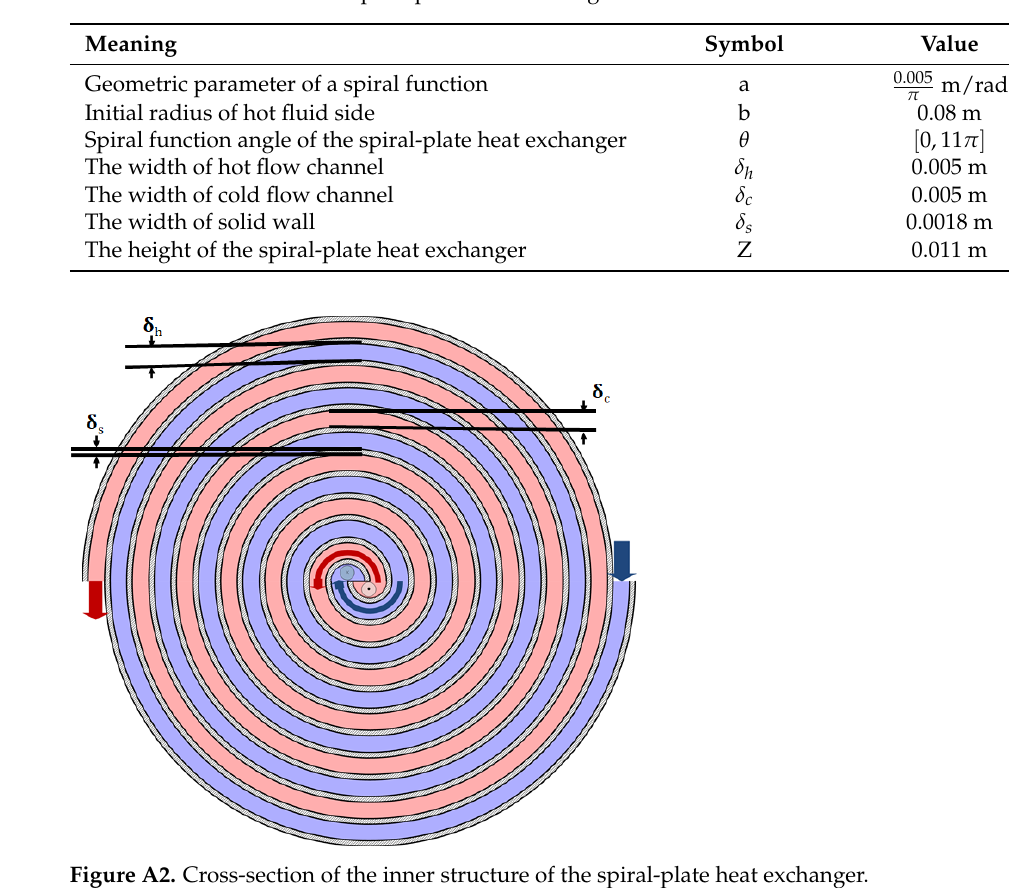
Table A1. Parameters of the spiral-plate heat exchanger.